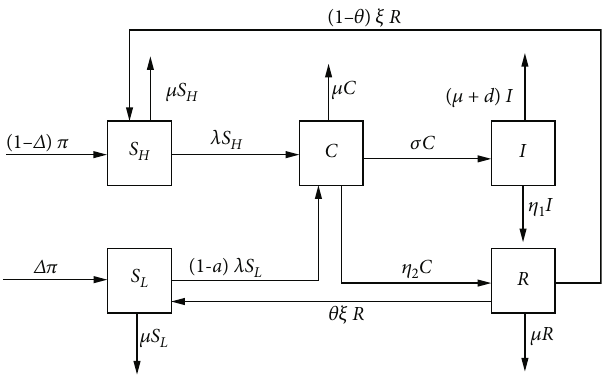
Figure 2: Schematic diagram of the low- and high-risk susceptible- carrier-infected-recovered (SCIR) model depicting meningitis transmissions between di ff erent compartments. The fi ve squares represent the compartments of individuals while the movement between the compartments is indicated by the black